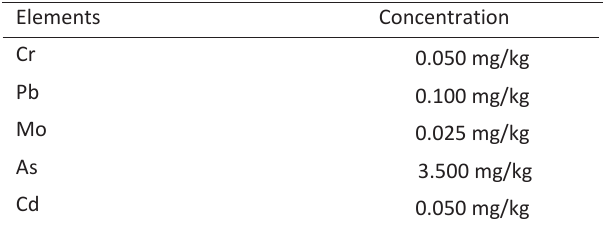
Table 1 - EU Heavy metal security limits (EC